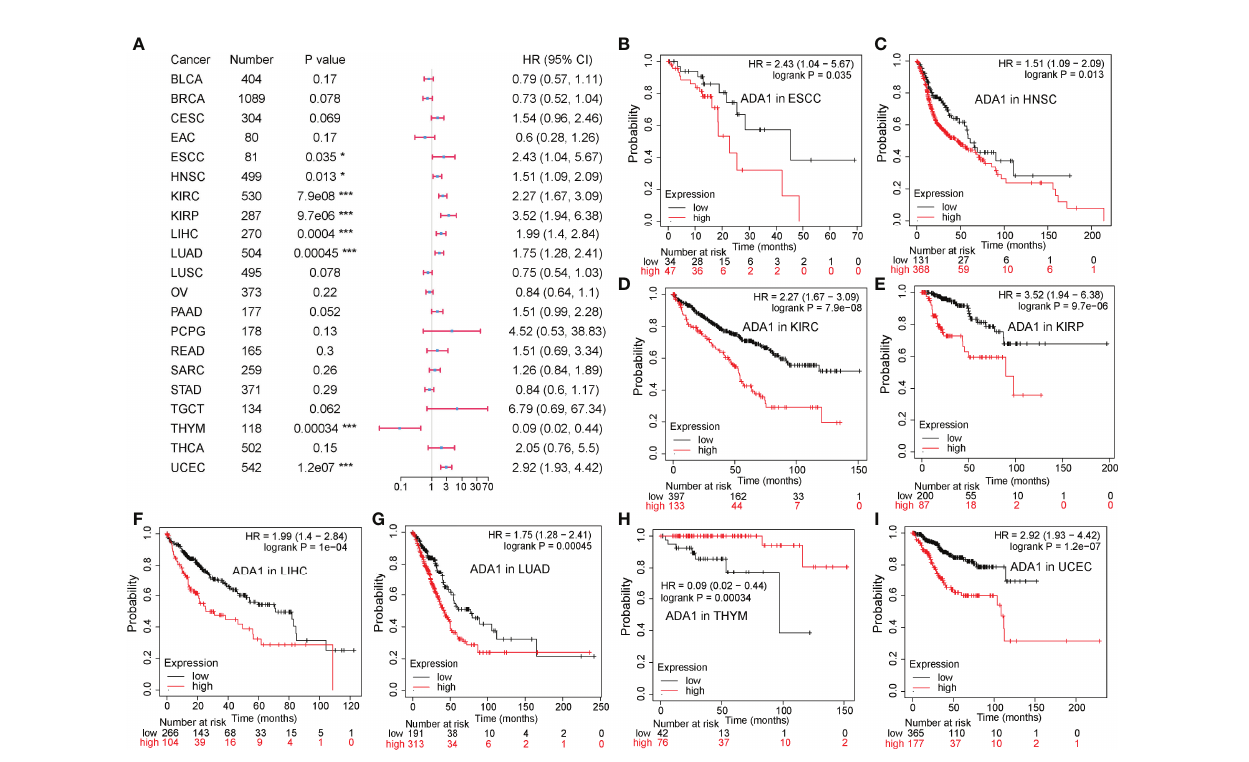
FIGURE 2 | Prognostic value of ADA1 in different cancers. (A) Forest plots showed the relation between ADA1 expression and OS of cancer patients. (B – I) Survival curves of ESCC, HNSC, KIRC, KIRP, LIHC, LUAD, THYM, and UCEC. *p < 0.05, ***p < 0.001. OS, overall survival; ESCC, esophageal squamous cell carcinoma; HNSC, head and neck squamous cell carcinoma; KIRC, kidney renal clear cell carcinoma; KIRP, kidney renal papillary cell carcinoma; LIHC, liver hepatocellular carcinoma; LUAD, lung adenocarcinoma; THYM, thymoma; UCEC, uterine corpus endometrial